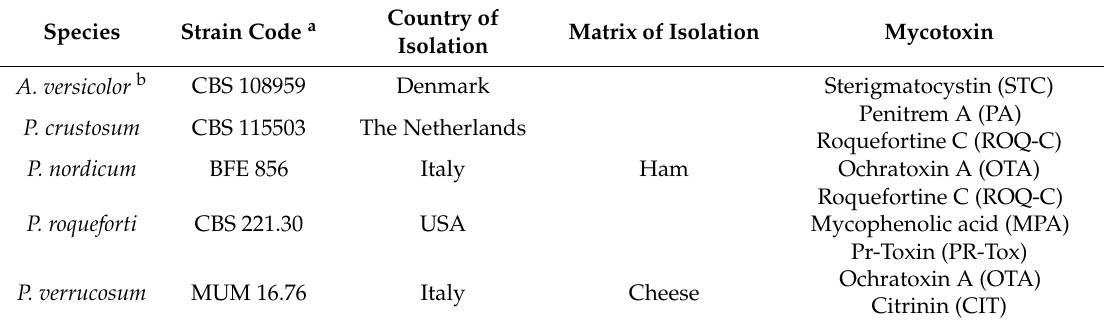
Table 1. Fungal strains used in this study, with the country, matrix of isolation, and mycotoxins reported in literature for these fungal